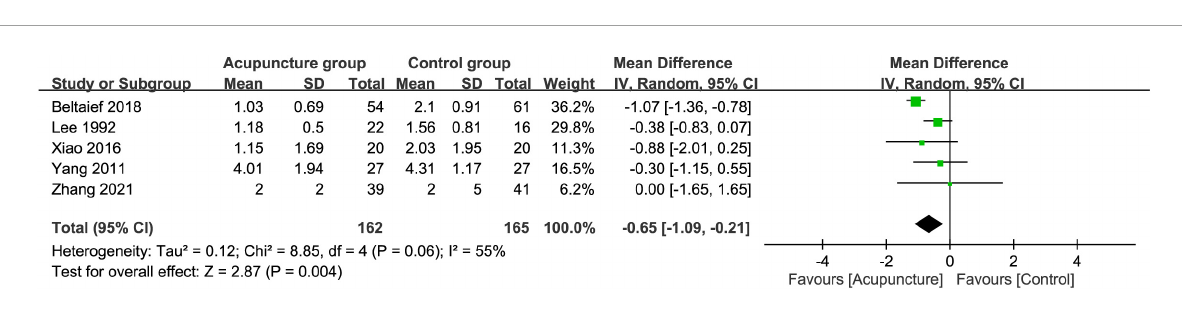
FIGURE10 Forest plot comparing pain score at 30–60 min between acupuncture and control groups. CI, confidence interval; IV, inverse